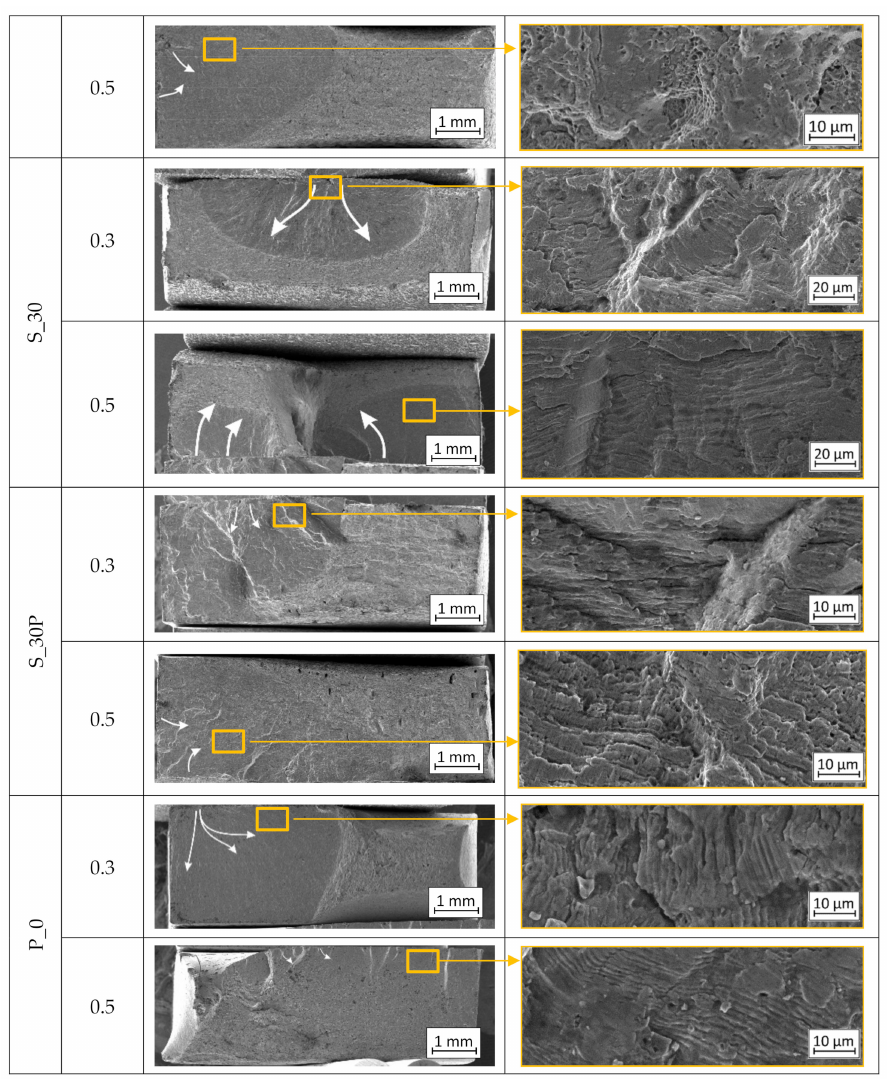
Figure 10. Fractures of low-cycle tested samples (( a )—macrostructure image, ( b )—microfracture with visible fatigue